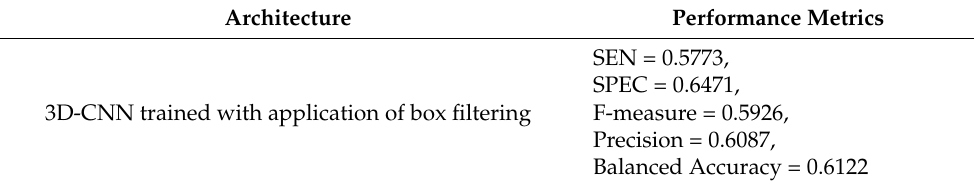
Table 5. Result of binary classification between MCI and NC